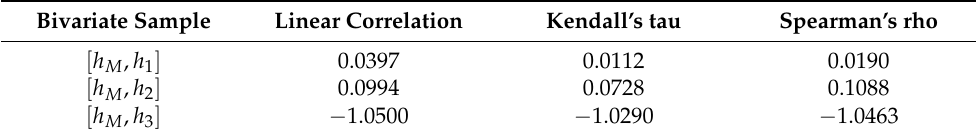
Table A6. Dependency measures between the two vectors of innovations.